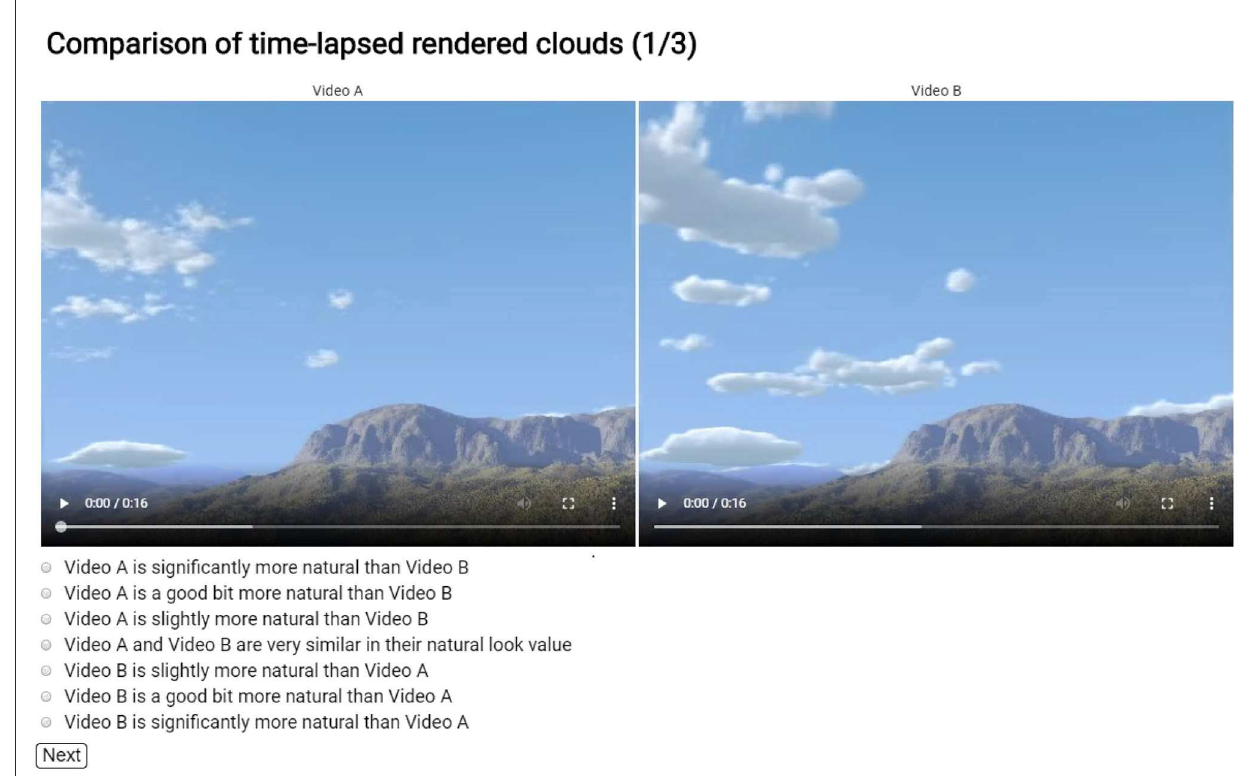
FIGURE5 Sample screenshot of the questionnaire page presented to the participants.